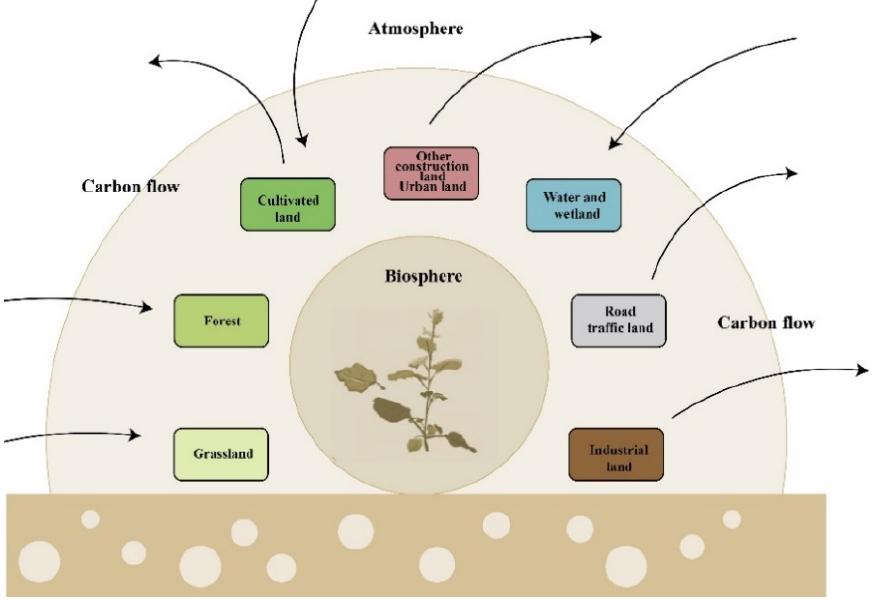
Figure 2. Spatial network model of carbon metabolism.